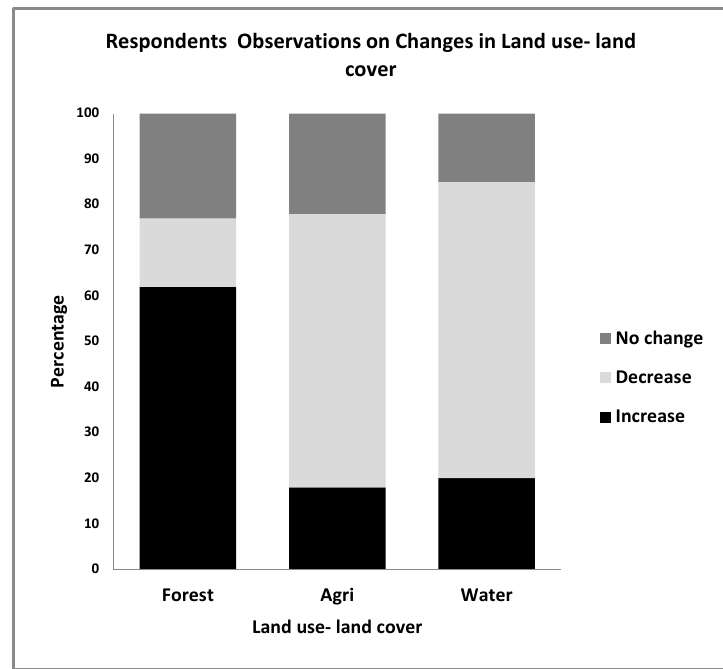
Figure 6. Respondents’ observations on local land use change during the last 20 years from 1995 to 2015.